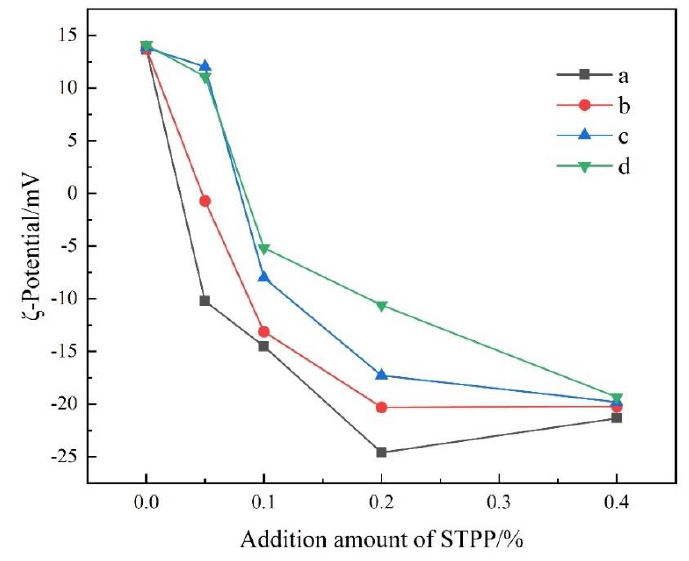
Figure 4. ζ − potential of cement particles as a function of the additional amount of STPP and stirring time: (a) 5 min, (b) 10 min, (c) 15 min, and (d) 20 min.